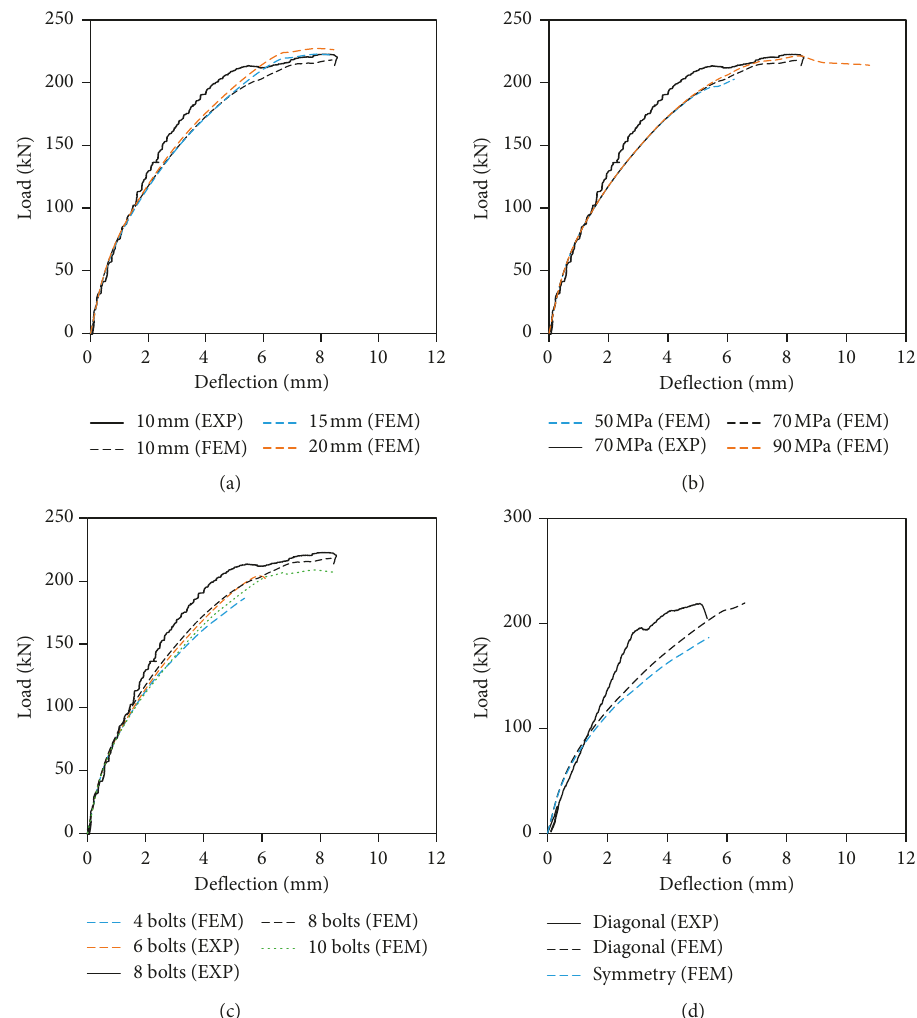
Figure 18: Load-deflection curves of the parametric study. Effect of (a) panel thickness; (b) compressive strength of SFRC; (c) number of bolts (symmetrical pattern); (d) bolt